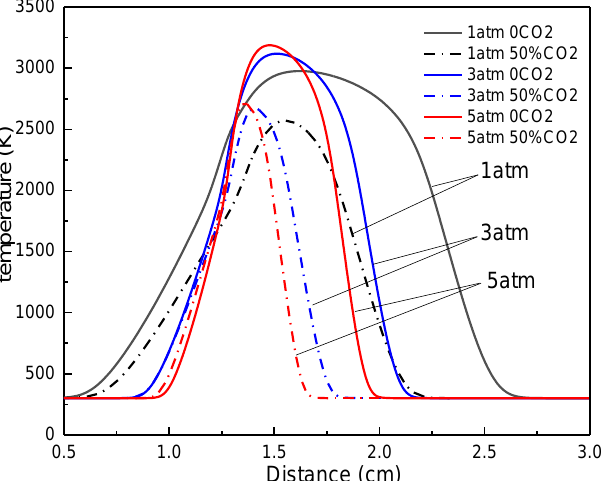
Figure 5. The effect of CO 2 on the flame temperature at different pressure (1–5 atm); 𝛼 𝑠 = 10 s −1 ; β = 0%, 50%.